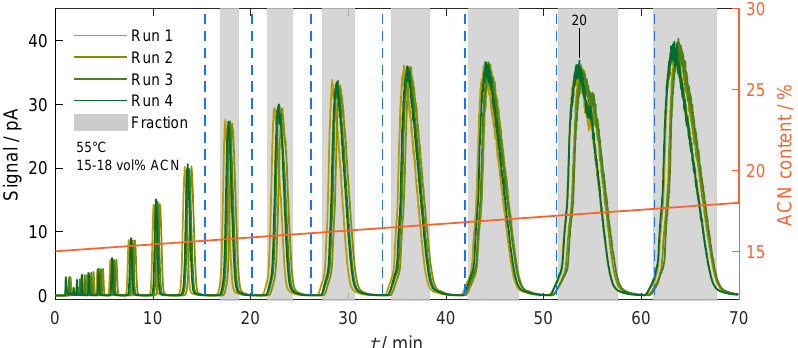
Figure 11. Overlay of four preparative production runs performed with automated fraction collection to obtain the homologs, with n = 14 through n = 21 as products. Gray areas—Collected product fractions, blues dashed lines—retention times calculated from the LSS model. Fraction collector parameters: minimum peak height 2 pA, minimum start time 15 min. For chromatographic conditions,